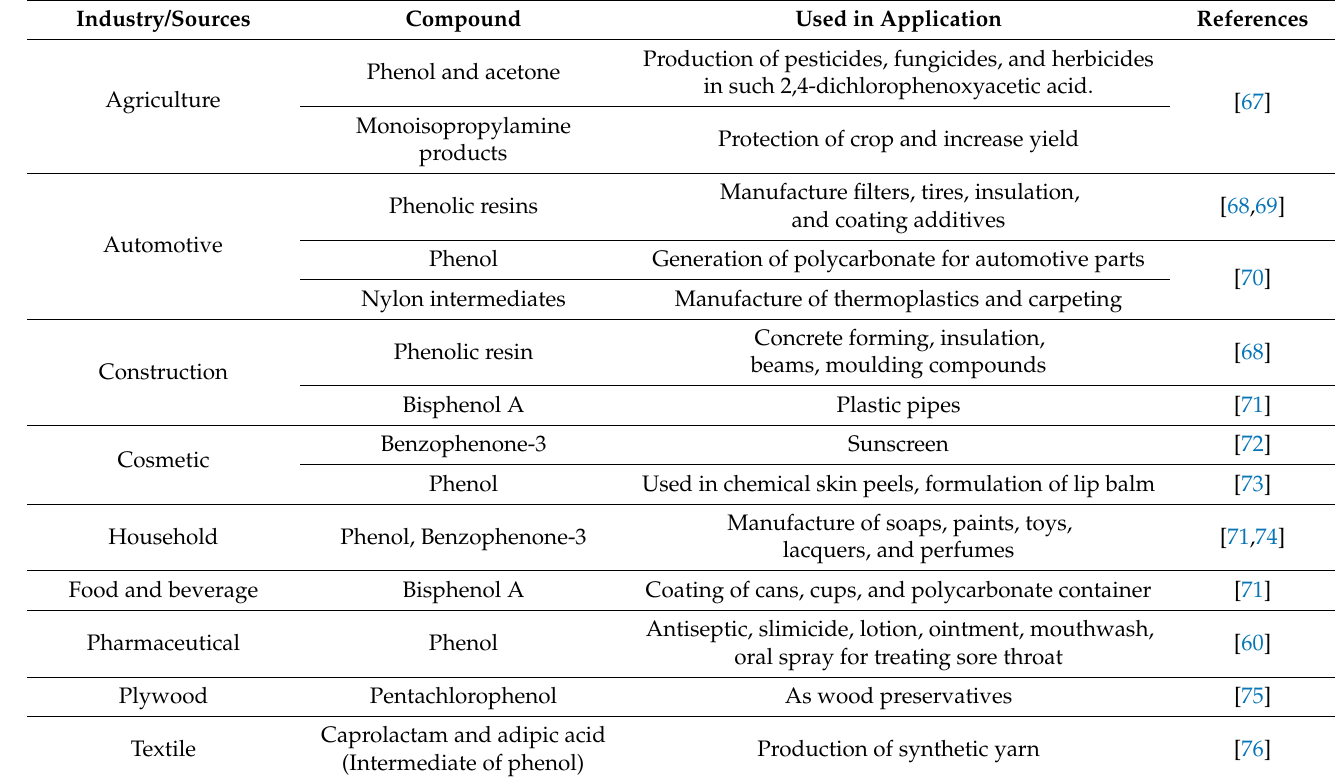
Table 10. The sources and application of phenolic compounds in various